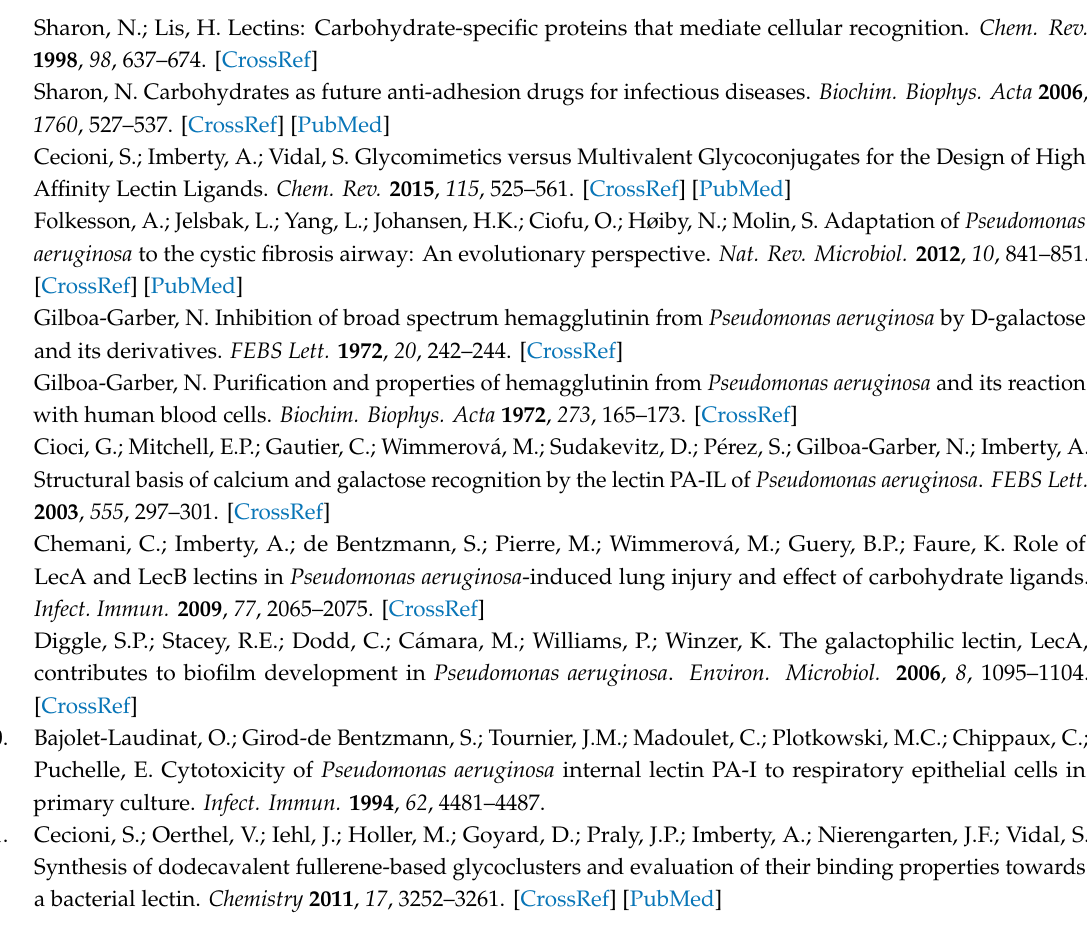
Figure S1: Continuous c(s) distributions of PA-IL samples obtained in the absence and presence of d -galactose. Figure S2: Cross-linking of Pseudomonas aeruginosa cells with d -galactopyranoside-presenting inhibitors. Results for compounds 7 and 13 . Figure S3: Cross-linking of Pseudomonas aeruginosa cells with d -galactopyranoside-presenting inhibitors. Results for compounds 4 and 10 . Figure S4: 1 H, 13 C NMR, COSY and HSQC spectra of compound 4 . Figure S5: 1 H, 13 C NMR, COSY and HSQC spectra of compound 7 . Figure S6: 1 H, 13 C NMR, COSY and HSQC spectra of compound 10 . Figure S7: 1 H, 13 C NMR, COSY and HSQC spectra of compound 13